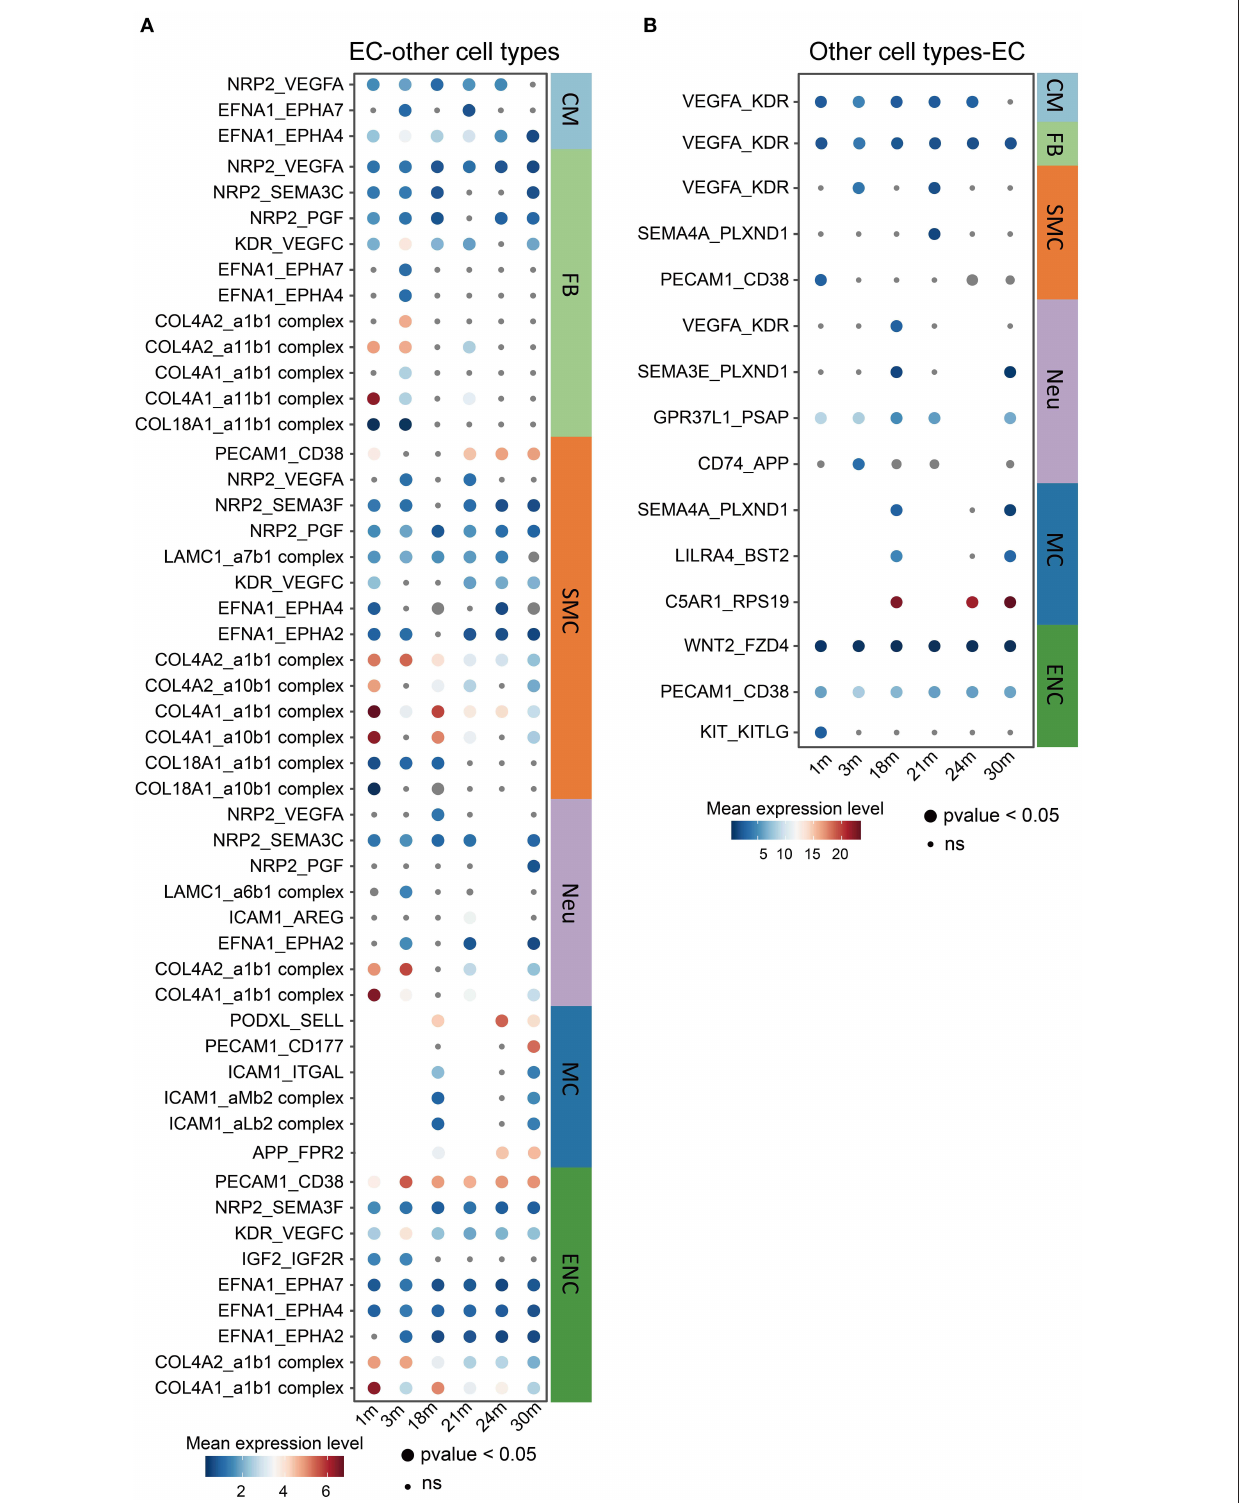
FIGURE 4 | Changes in ligand-receptor interactions between cardiovascular ECs and other cell types during aging. (A,B) Changes of selected ligand-receptor interactions between ECs and other cell types ( A : ECs express the specific ligand. B : receptor) during aging. CM, cardiomyocyte; MC, mast cell; FB, fibroblast; ENC, endocardial cell; EC, endothelial cell; WBC, leukocyte; RBC, erythrocyte; SMC, smooth muscle cell; Neu, cardiac neuron. Dot size represents the p -value. The color key indicates the mean expression level of each interacting pair.